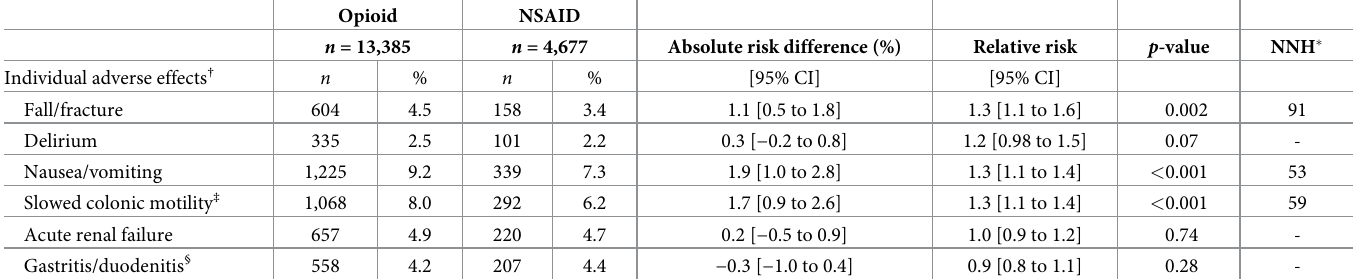
Table 3. Incidence, absolute risk difference, and relative risk of individual adverse effects for opioids compared to NSAIDs in the propensity-matched cohorts ( n = 18,062). Opioid